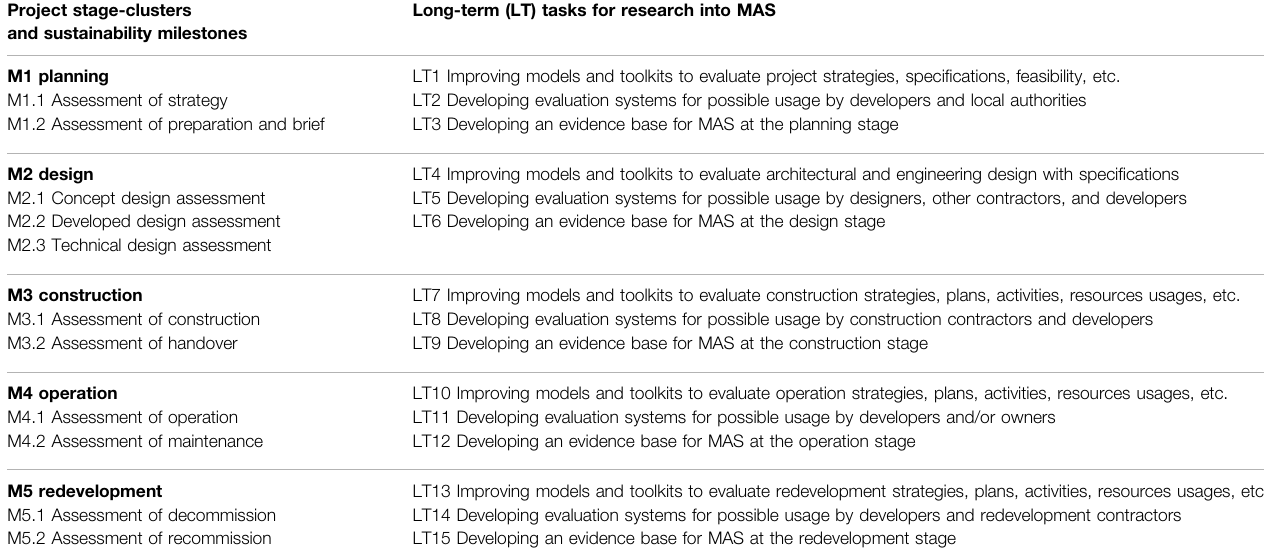
Long-term (LT) tasks for research into